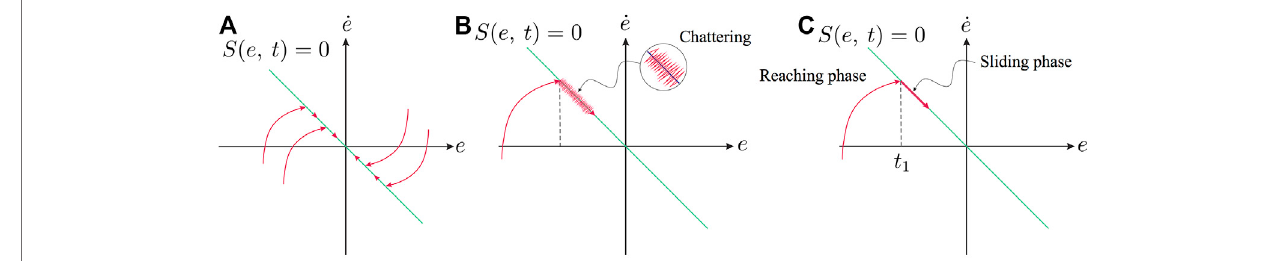
FIGURE 10 | Graphic interpretation of the SMC. (A) Reaching phase. (B) Chattering (C) Sliding